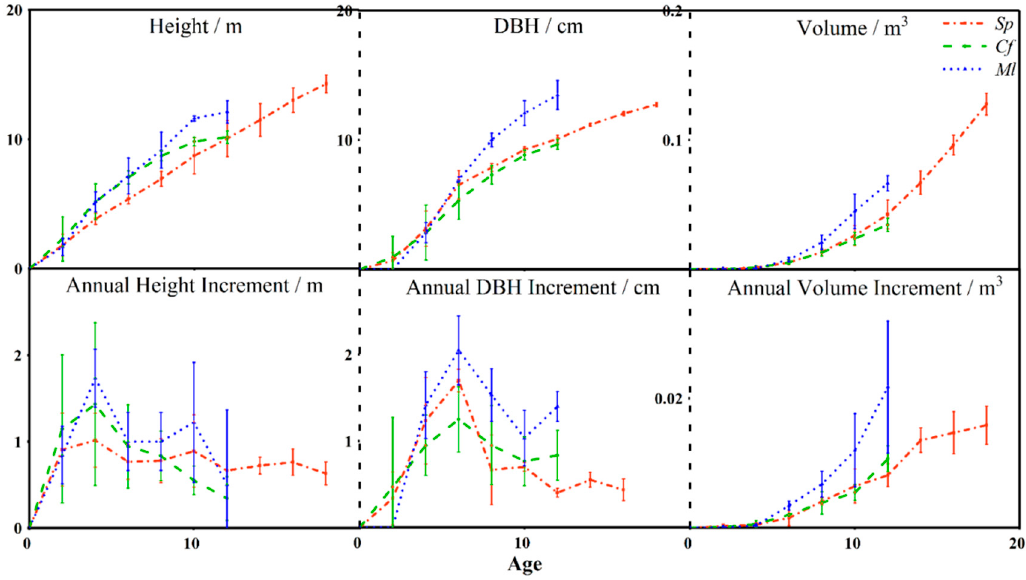
Figure 4. Development of height (m), DBH (cm) and volume (m 3 ) as well as their annual increments of the three tree species (Red: Sp ; Green: Cf ; Blue: Ml ). The panel represents the mean value and error bars indicate standard deviation.